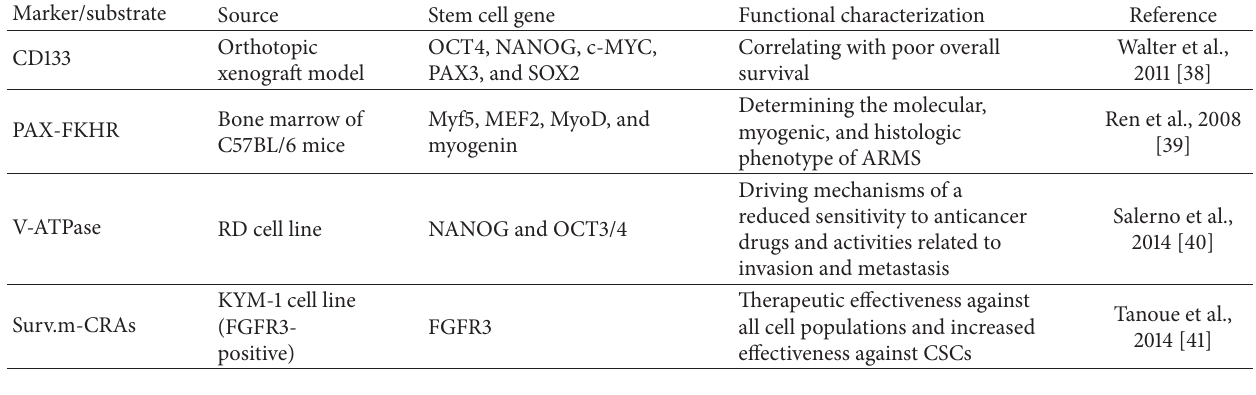
Table 3: Studies identifying stem cells in RMS.